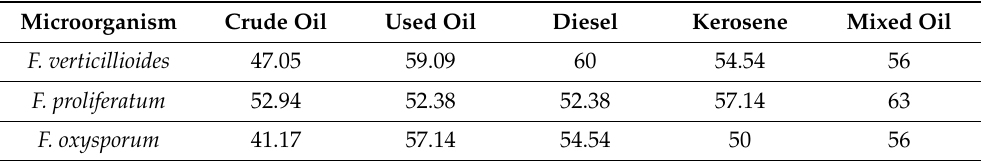
Table 5. Emulsification activity of CFSs (%) produced by different strain of Fusarium